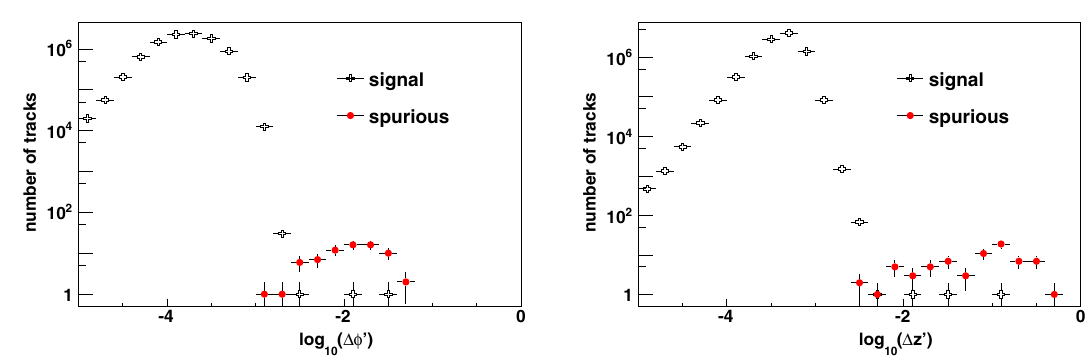
Figure 9. Distributions of consistency metrics �φ ′ (left) and (cid:31) z ′ (right) for tracks from a sample of 10 million signal particles, and spurious tracks from a sample of 20,000 simulated bunch